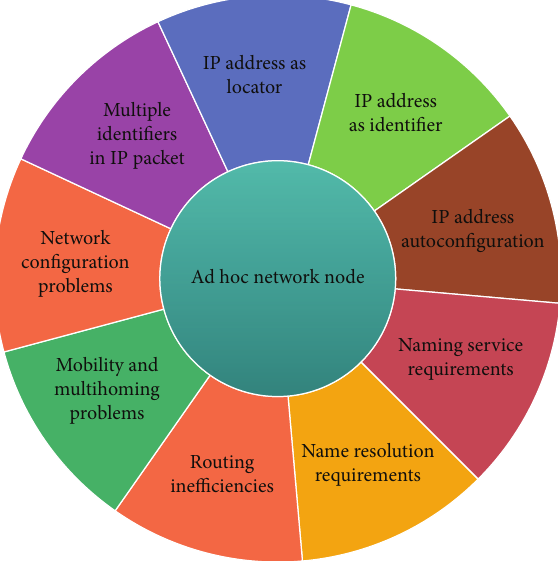
Figure 1: Problem circleof IP architecturebased ad